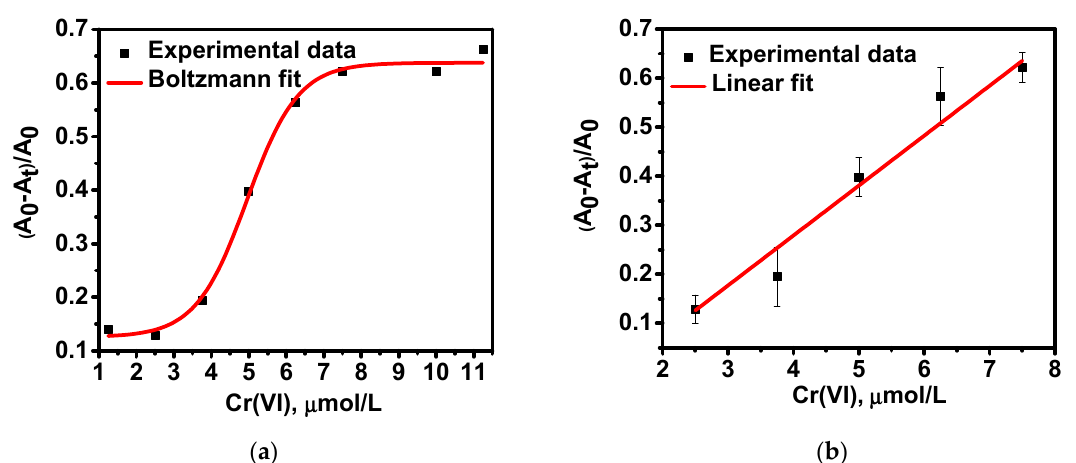
Figure 5. ( a ) Optical response of LSPR based sensor using raffinose capped silver nanoparticles as a function of Cr(VI) concentrations in the range 1.0–11.5 μ mol L − 1 and ( b ) calibration curve in the concentration range 2.5–7.5 μ mol L − 1 Cr(VI). R 2 = 0.9798.